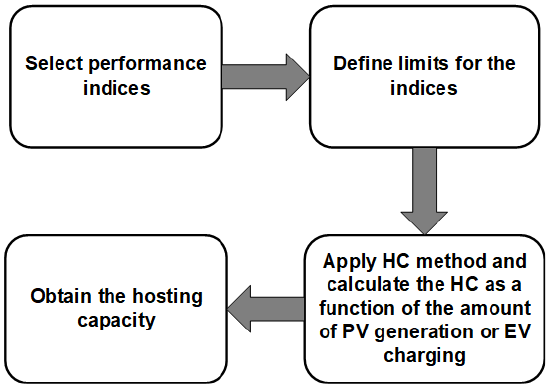
Figure 2. General hosting capacity approach.